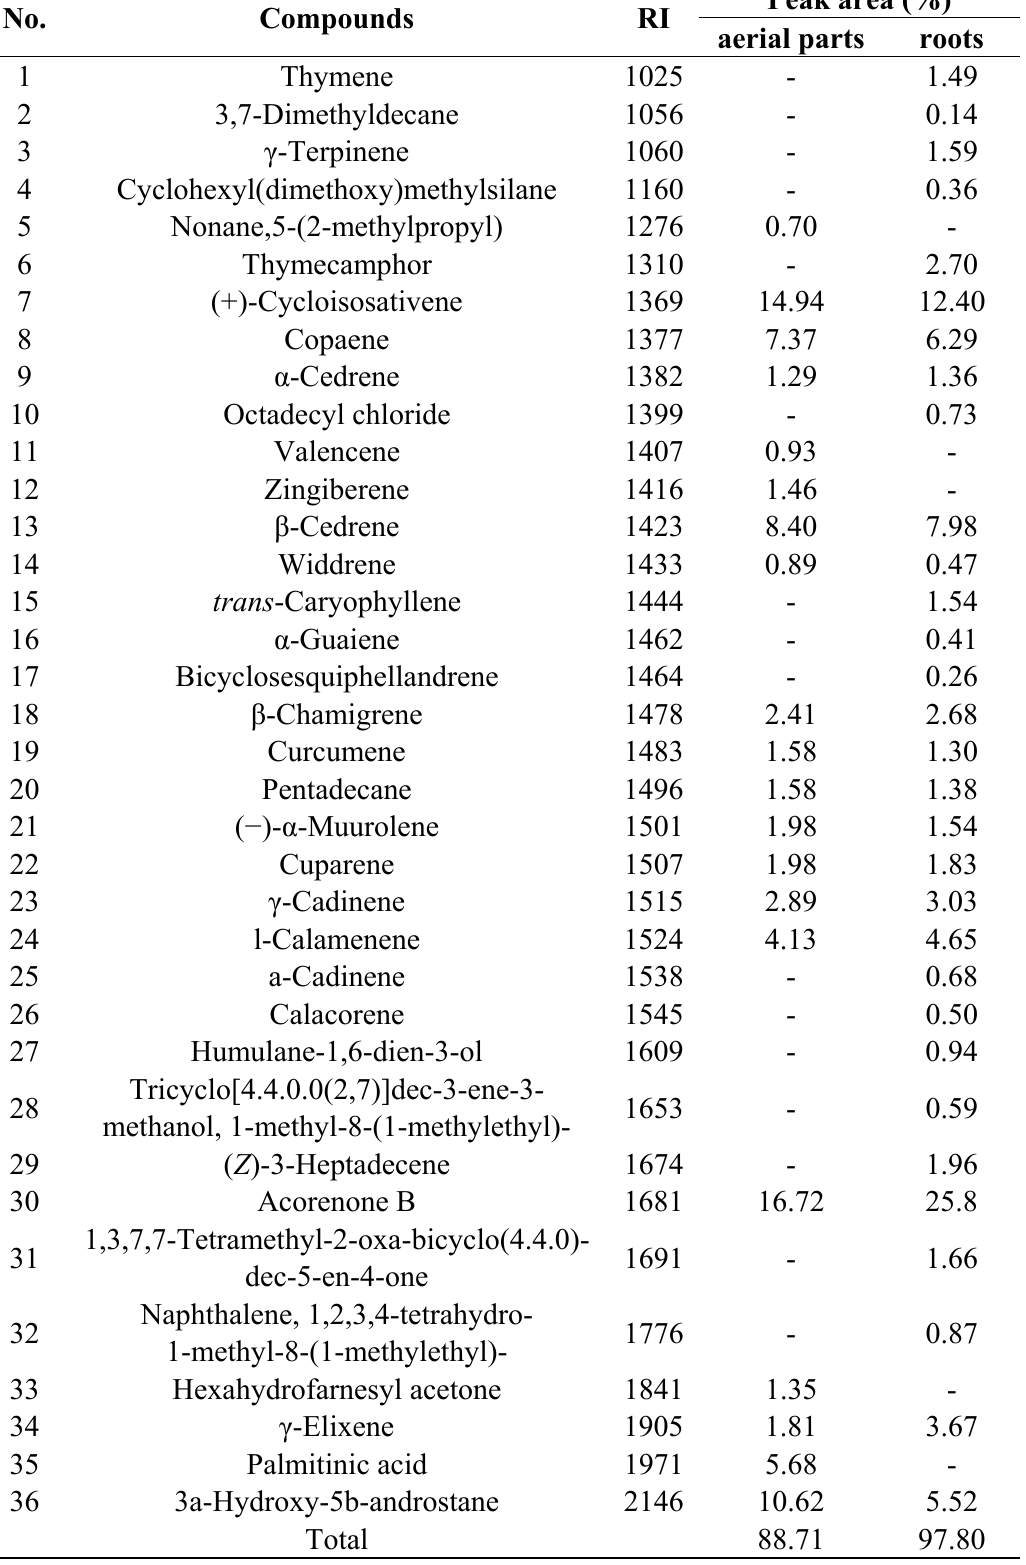
Table 1. Chemical composition of essential oils of E. macrorrhiza